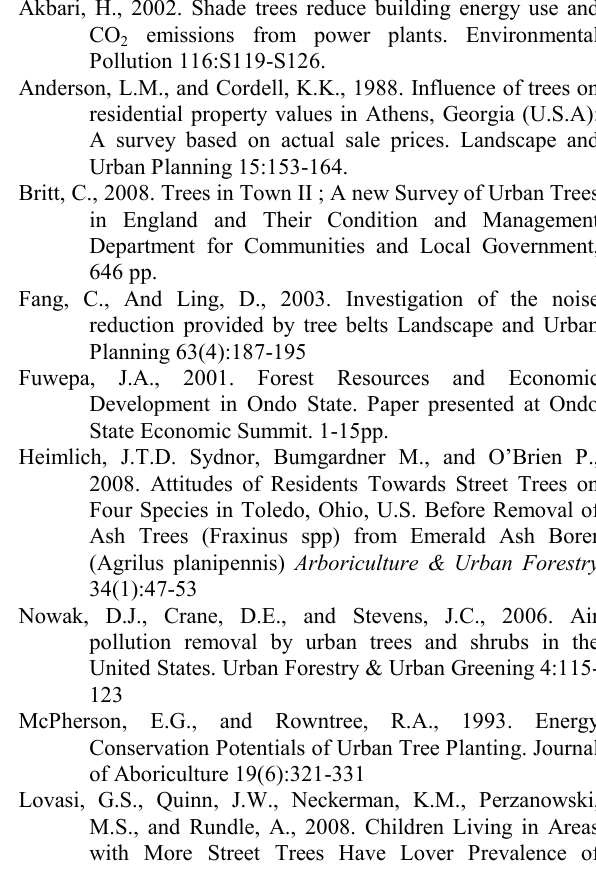
Figure 5. Query for Individual Avenue